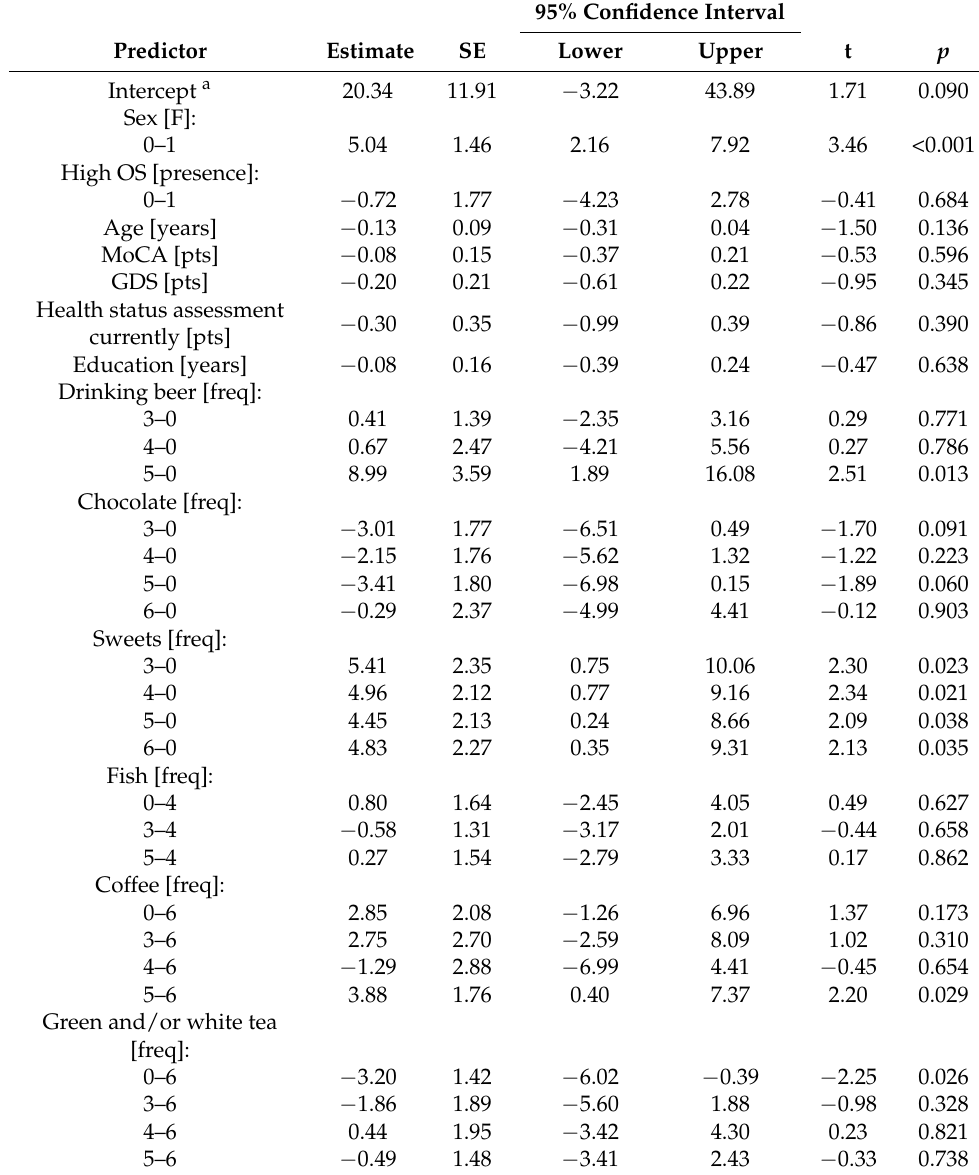
Table 1. Food product consumption frequencies as predictors of changes in body fat percentage within two